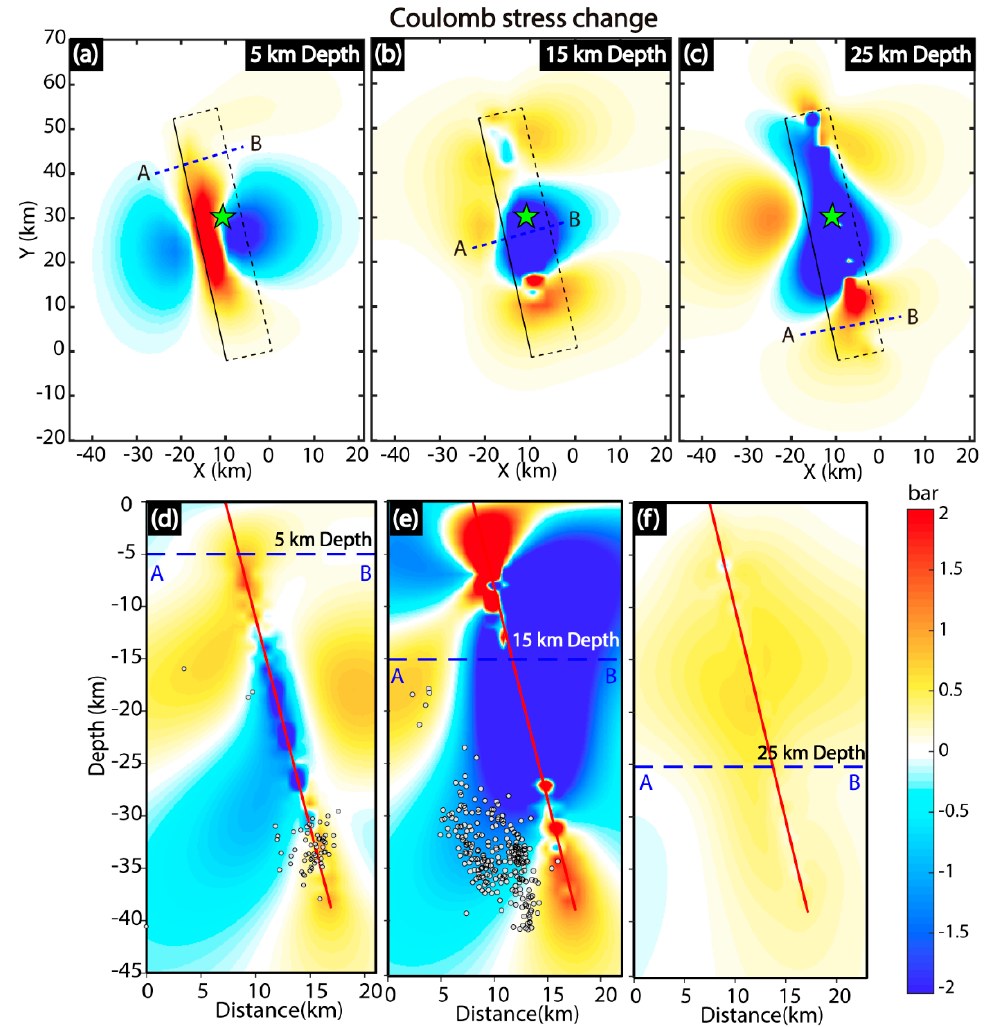
Figure 9. ( a - c ) Coulomb stress changes at depths of 5 km, 15 km, and 25 km. The dashed rectangle and green pentagram represent the fault plane and main shock, respectively. ( d - f ) Coulomb stress changes along profile AB, which corresponds to ( a - c ). The gray dots indicate the relocated aftershocks within ~2 days from Katsumata et al. [2].